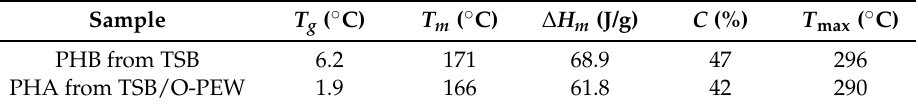
Table 2. Selected thermal properties of the obtained polyesters.